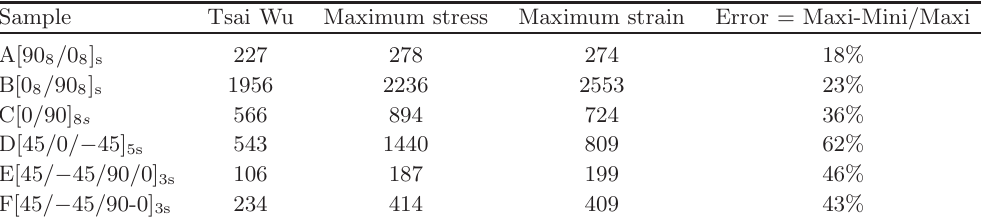
Table 9. First ply failure loads obtained by numercical analysis.